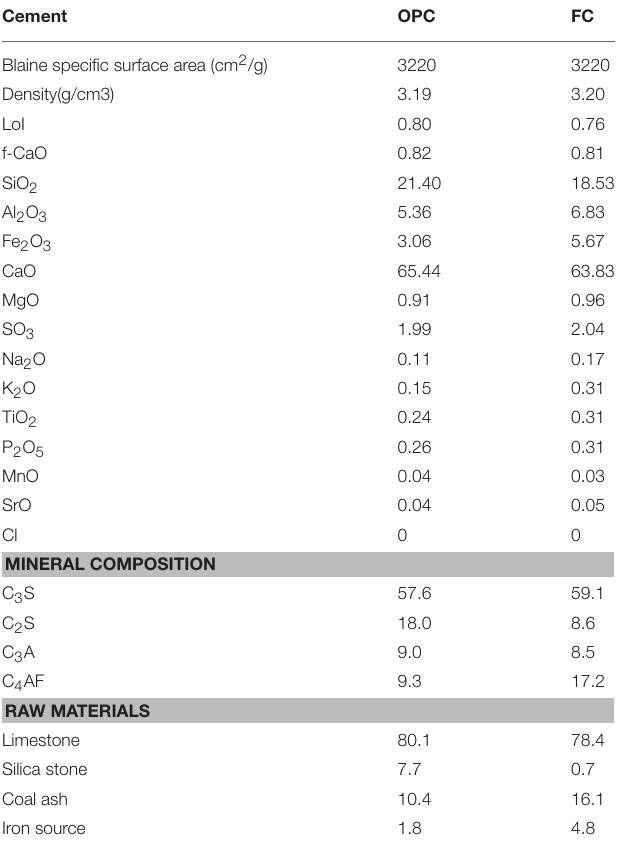
TABLE 1 | Physical properties and chemical composition of cements used (Oxide in wt.%). Cement